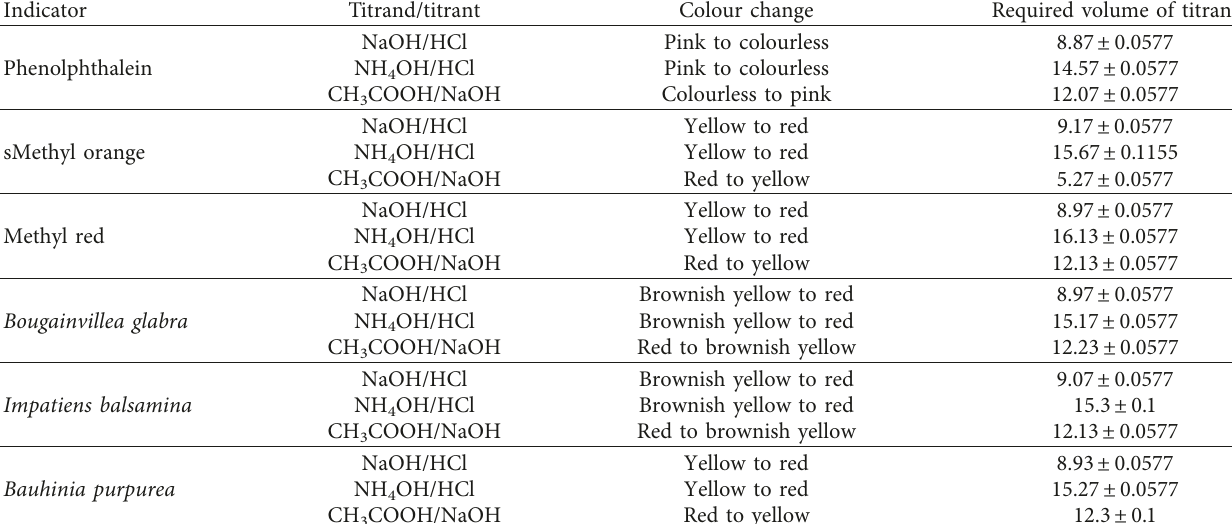
Table 3: Titration results of flower extracts and commercially available indicators. Indicator